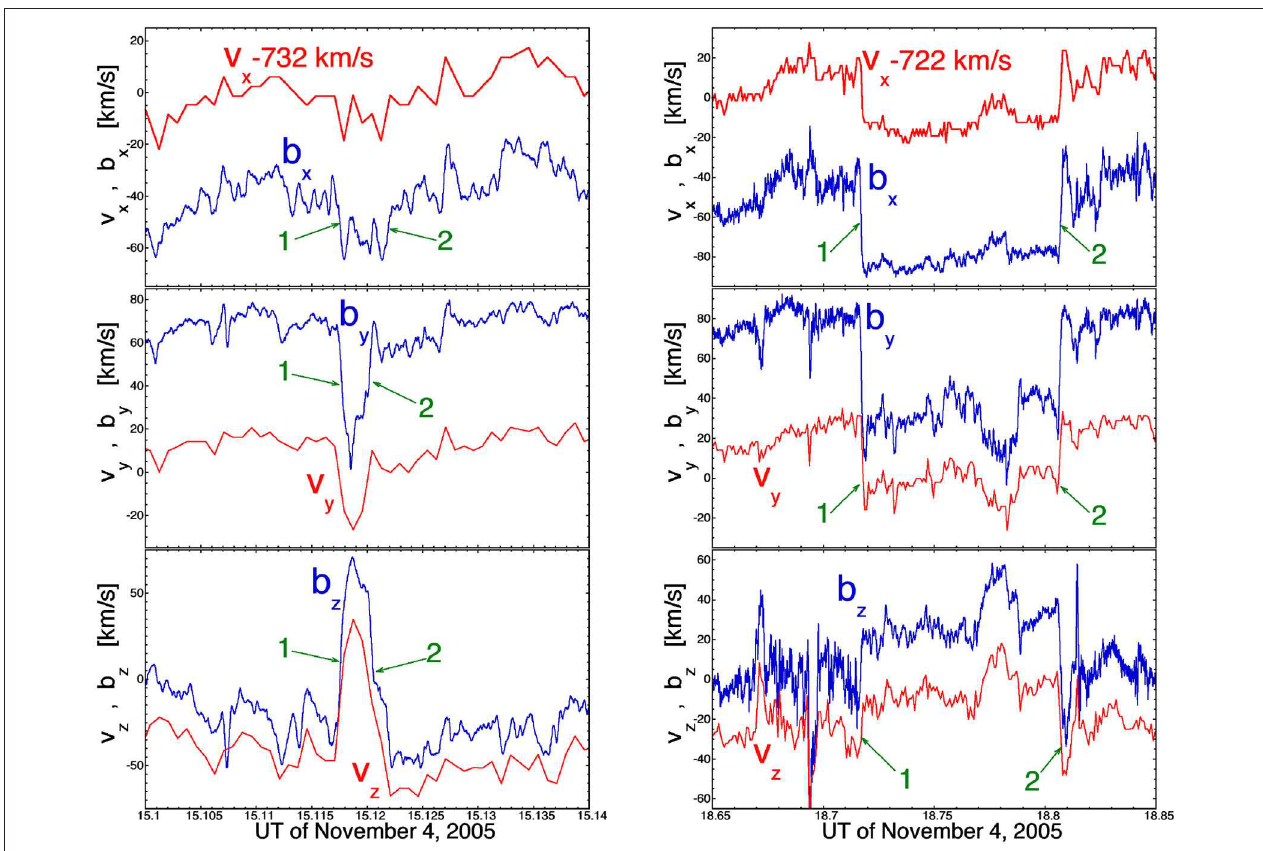
FIGURE 2 | Two examples of paired current sheets, one with an event duration of 16s (left panel) and one with a duration of 5.5min (right panel). The velocity (red curves) is measured with 3-s time resolution and the magnetic field (blue curves) is measured with 0.09375-s time resolution. The two current sheets marking the beginning and end of the event are indicated in each panel with green